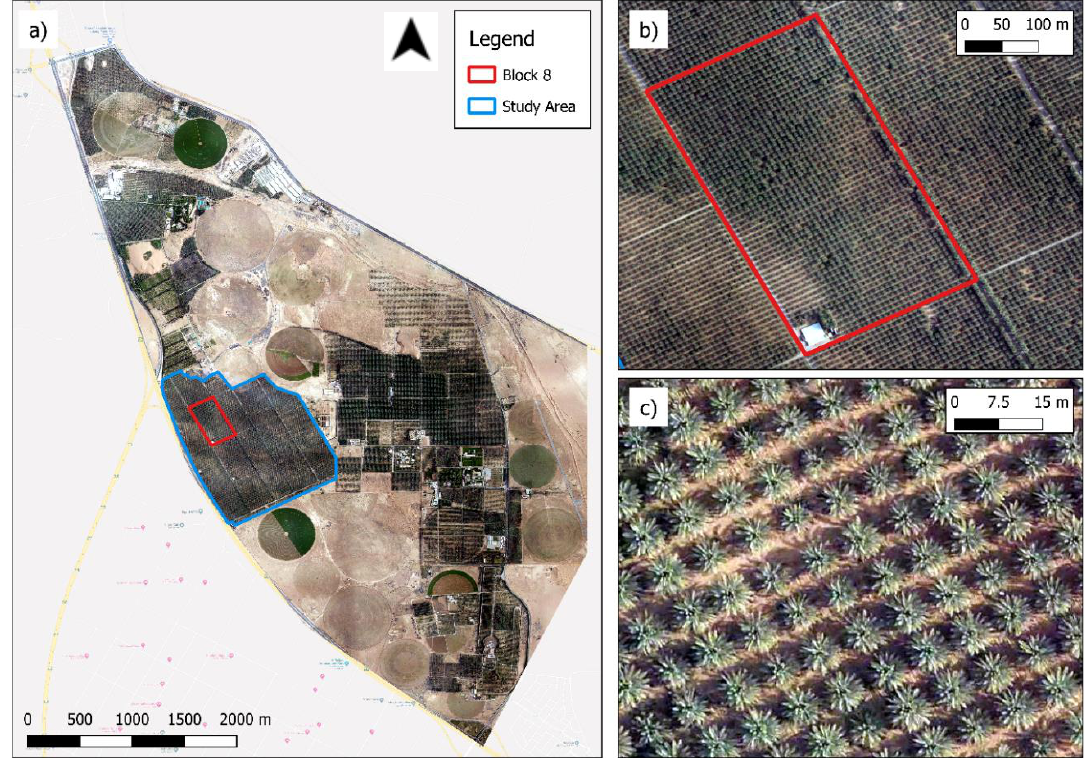
Figure 1. Visual red-green-blue (RGB) images with 15-cm resolution, taken using an aerial platform on 26 May 2016, of ( a ) the date palm plantation in the study area (outlined in blue), located south-east of Riyadh, the capital of Saudi Arabia; ( b ) an example of a block within the plantation (outlined in red) and ( c ) an example of individual palm trees.